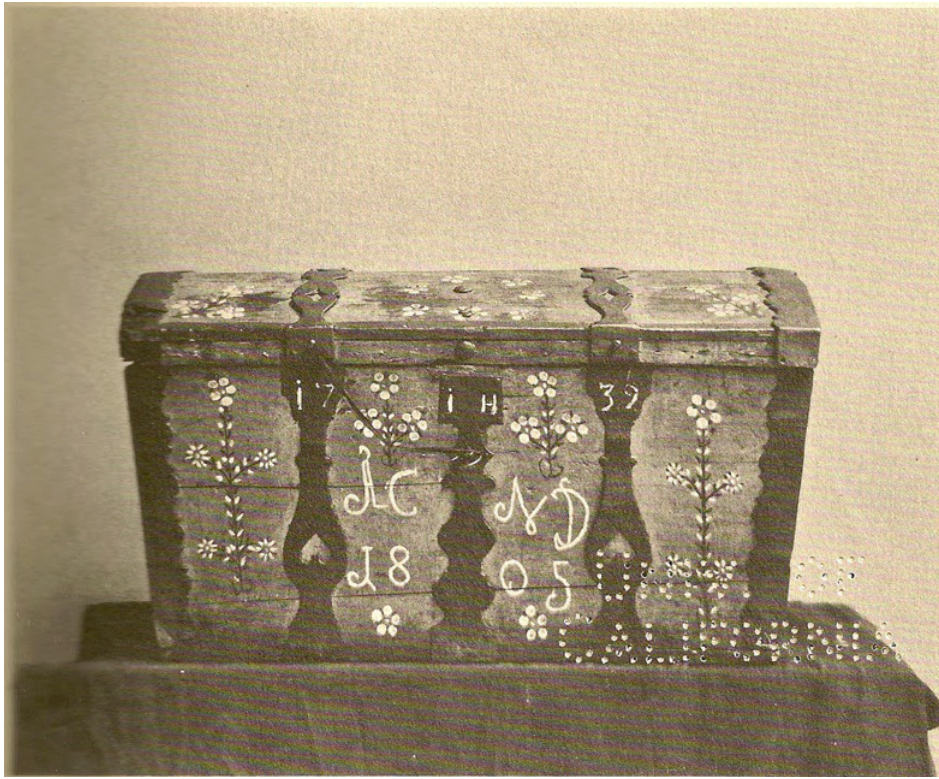
“Swedish Immigrant’s Trunk at Buffalo and Albany,” in Allen H. Eaton, Immigrant Gifts to American Life. © 1932 Russell Sage Foundation, 112 East 64 th Street, New York, NY 10065. Reprinted with Permission. Reprinting, reposting, or republishing is prohibited without written consent from the Russell Sage